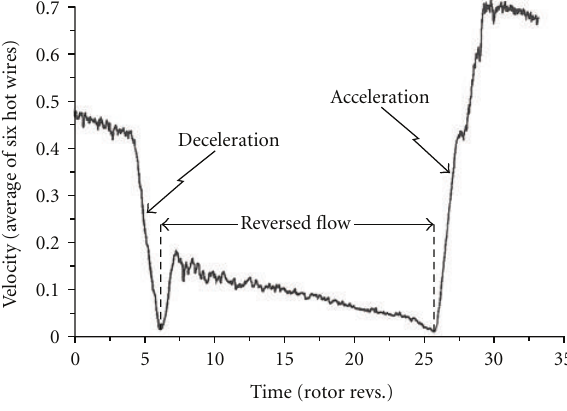
Figure 10: Average velocity from six hot wires downstream of compressor exit showing details of flow reversal during deep surge cycle in Day’s experiment tests